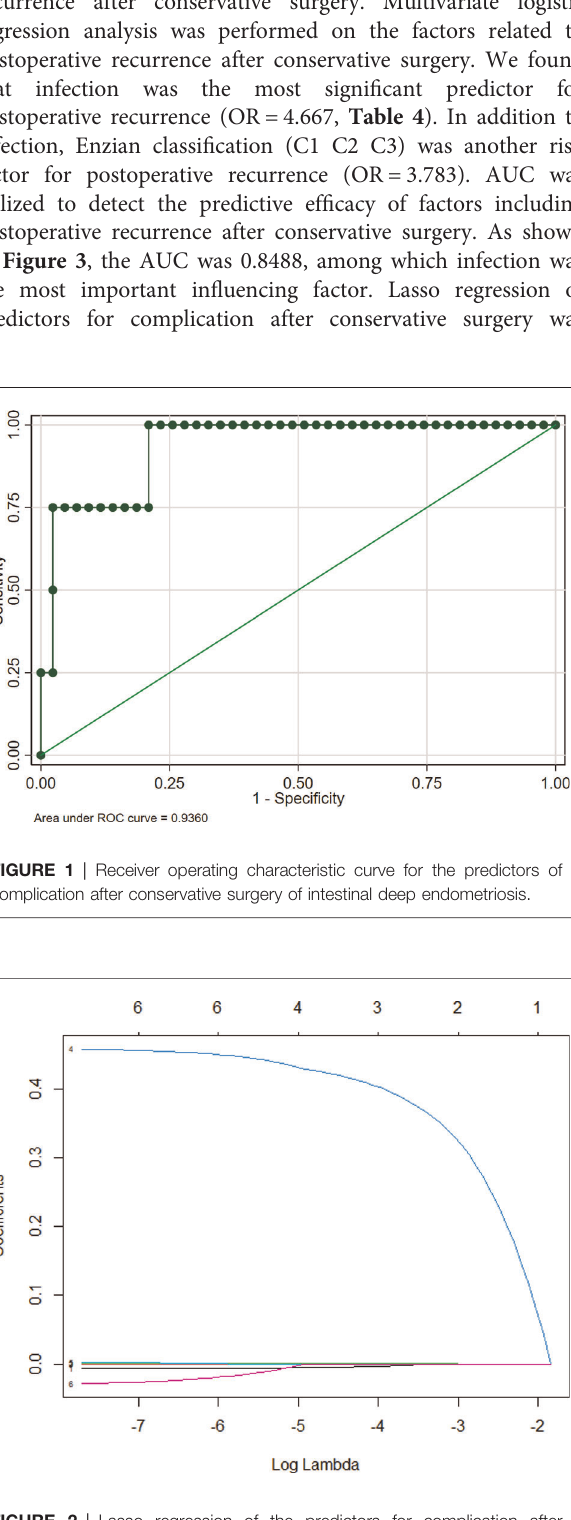
FIGURE 2 | Lasso regression of the predictors for complication after conservative surgery of intestinal deep endometriosis. 4, infection; 6, surgery